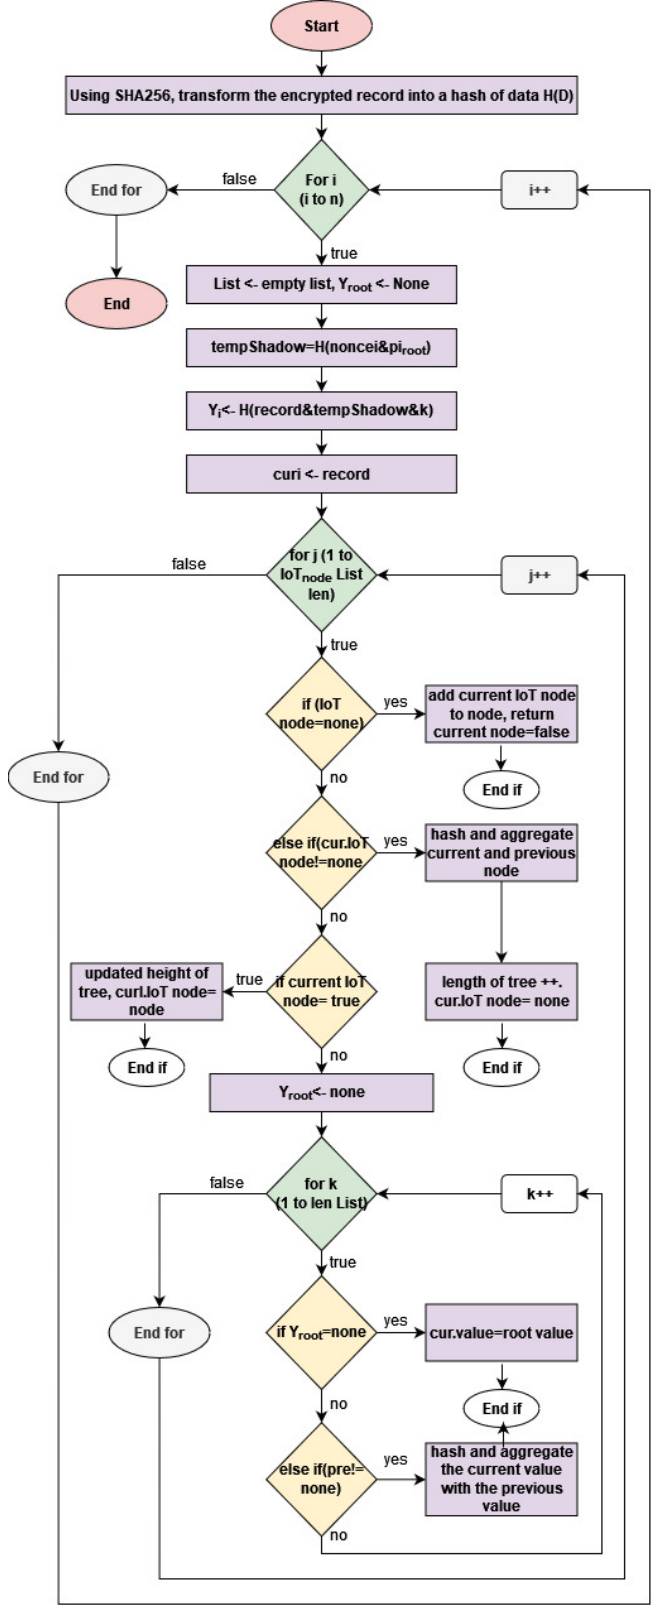
Figure 3. Proposed Algorithm Flow